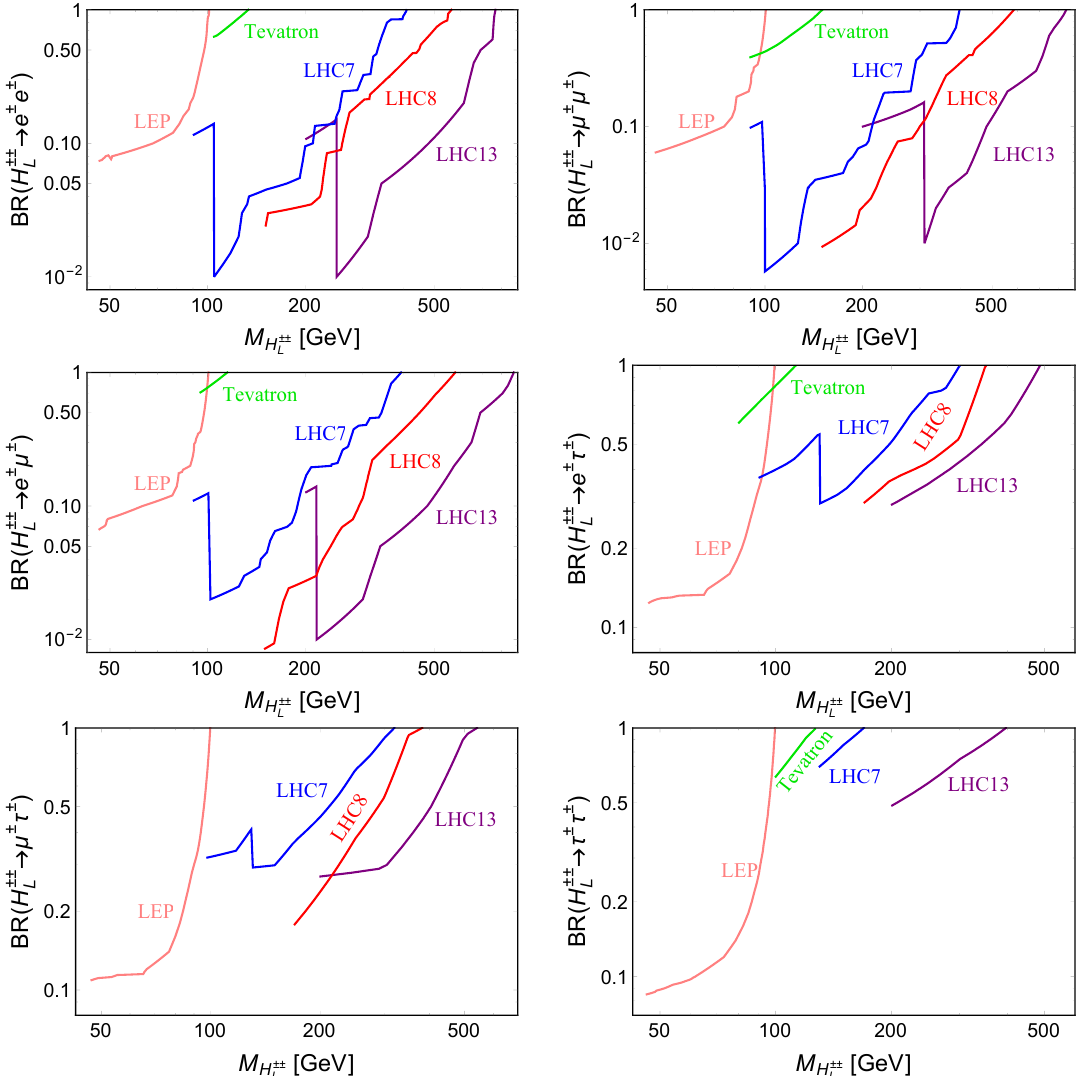
Figure 4 . 90% CL lower limits on M all the six (cid:13)avor combinations of ‘ (cid:11) ‘ (cid:12) = ee (upper left), (cid:22)(cid:22) (upper right), e(cid:22) (middle left), e(cid:28) (mid- dle right), (cid:22)(cid:28) (lower left) and (cid:28)(cid:28) (lower right) using the data from LEP [39{41], Tevatron